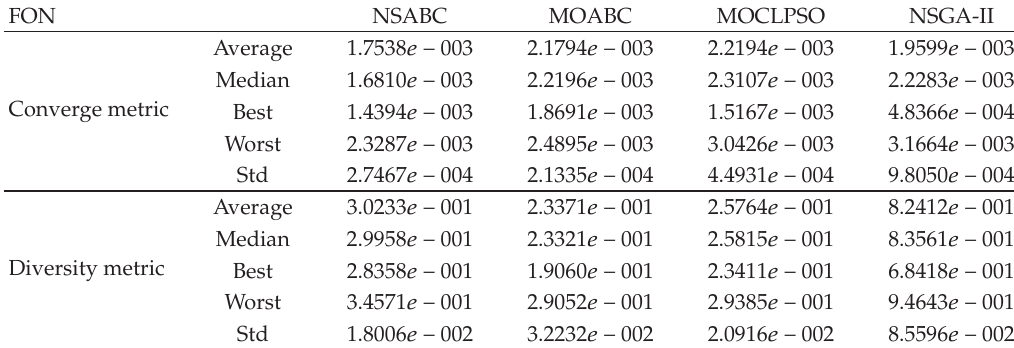
Table 4: Comparison of performance on FON after 20000